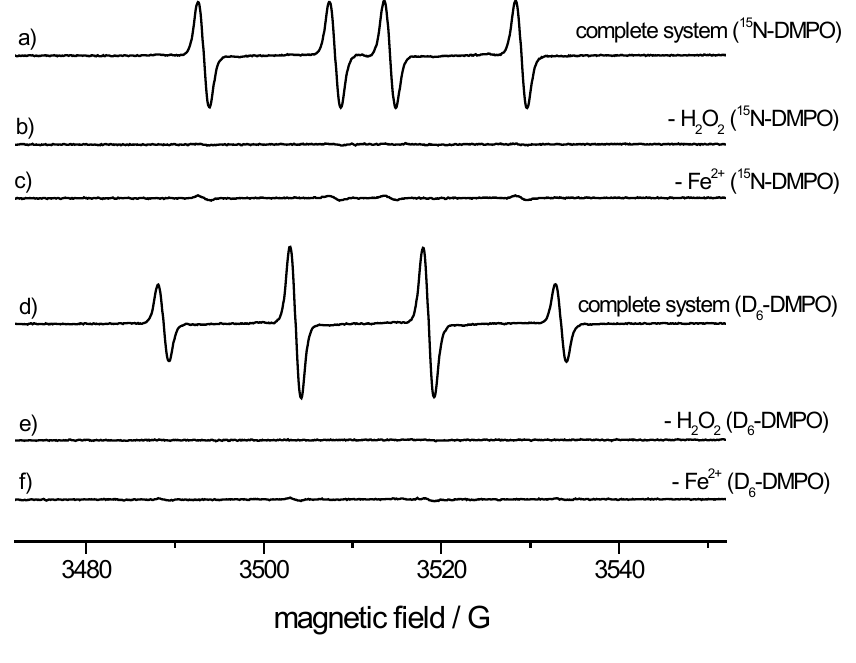
Figure 1. ESR spin trapping of hydroxyl radicals with 100 mM 15 N- or di(trideuteromethyl) DMPO. Radicals were generated with a Fenton System (100 μM FeSO 100 mM phosphate buffer, pH 7.4, with 200 μM DTPA). A strong signal was detected